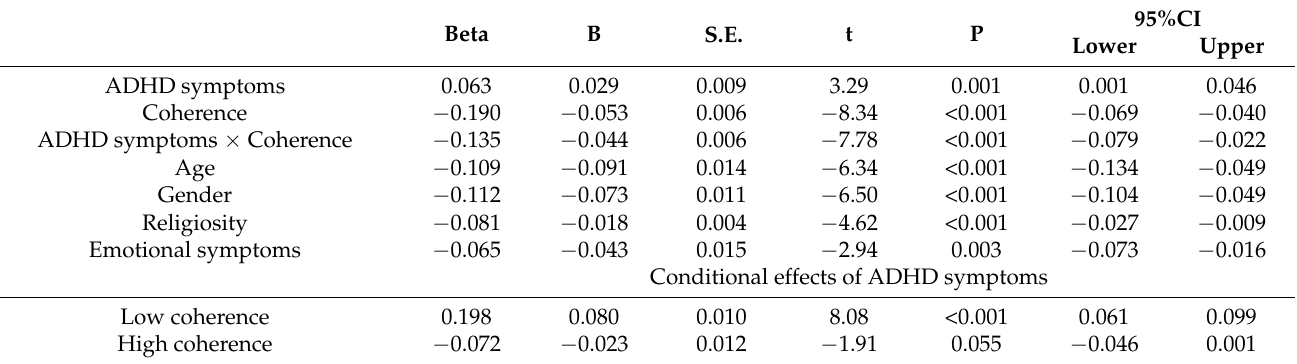
presented at the bottom of Table 7 and Figure 5, indicates that ADHD symptoms predicted public order antisocial behavior more strongly when coherence was low than